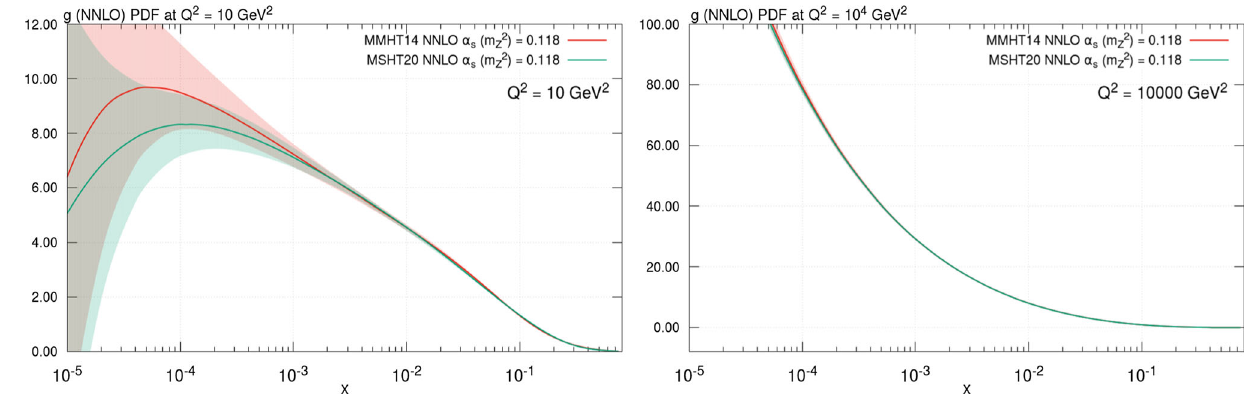
Fig. 16 Gluon PDF for MSHT20 and MMHT14, at NNLO and (left) Q 2 = 10 GeV 2 and (right) Q 2 = 10 4 GeV 2